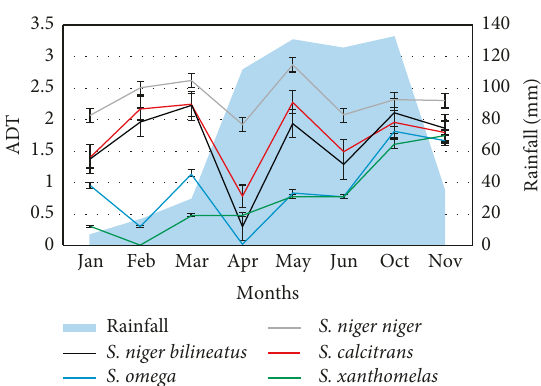
Figure 2: Monthly evolution of the ADT of Stomoxys spp. and rainfall. ADT: trap apparent density.